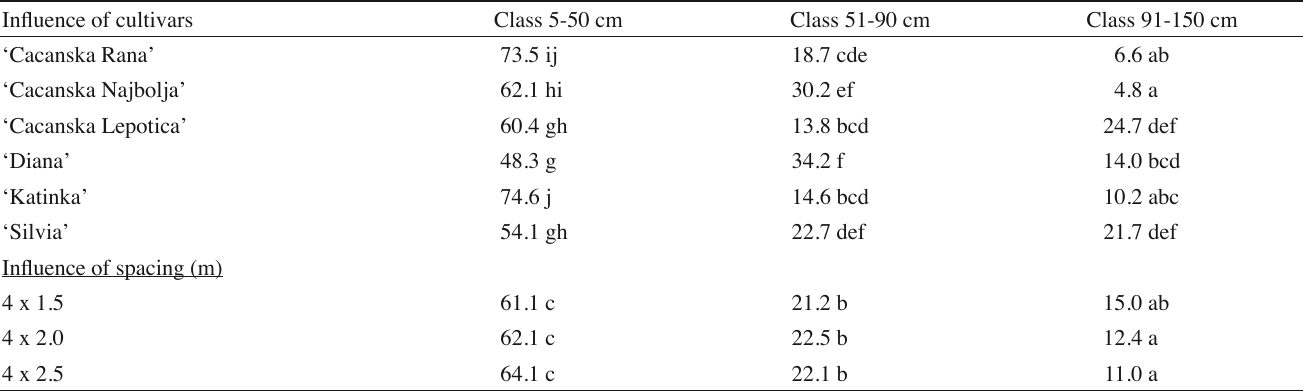
Different letters indicate significant differences separately for cultivars and spacing at P=0.05.